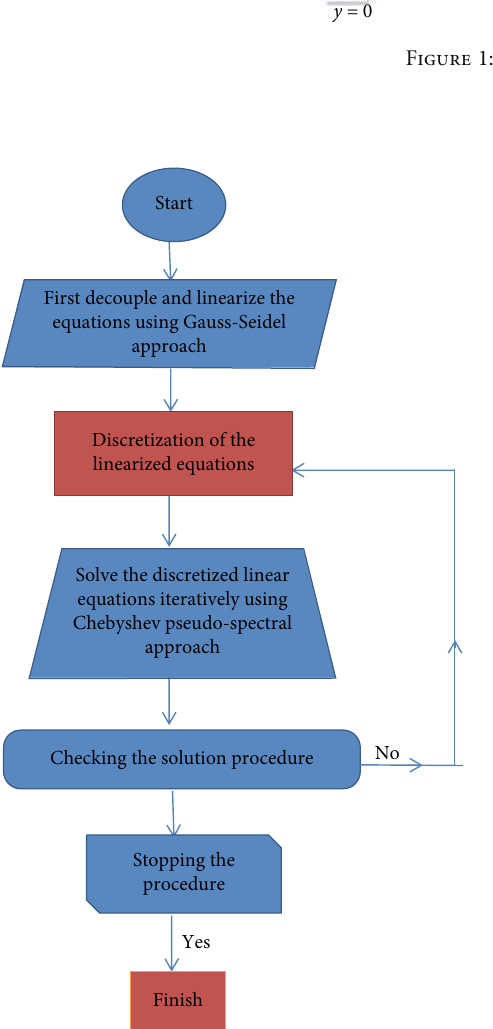
Figure 2: Flow diagram of the present solution